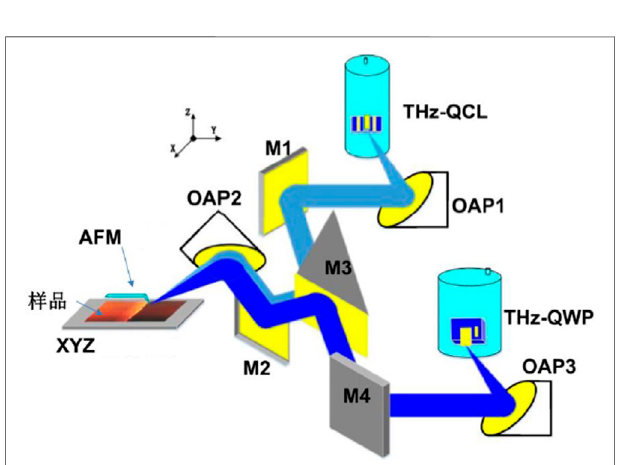
FIGURE 5 | The THz scanning near- fi eld optical microscopic imaging system [30].